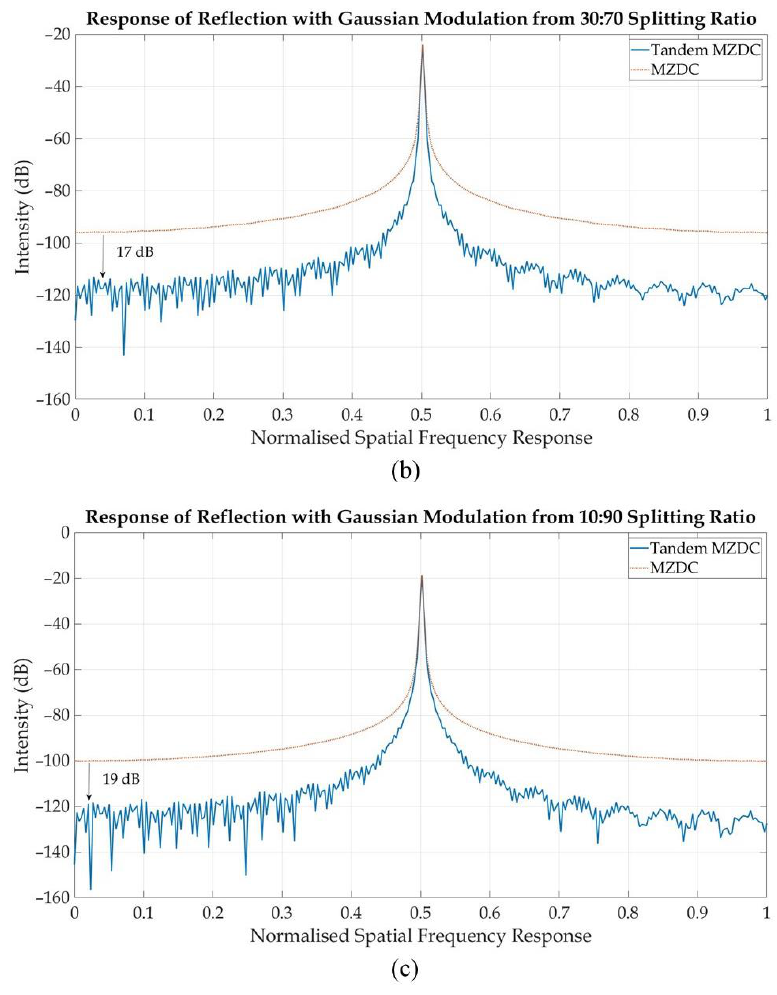
Figure 10. Spatial response of MZDC and tandem MZDC with: ( a ) 50:50 splitting ratio, ( b ) 30:70 splitting ratio, and ( c ) 10:90 splitting ratio.